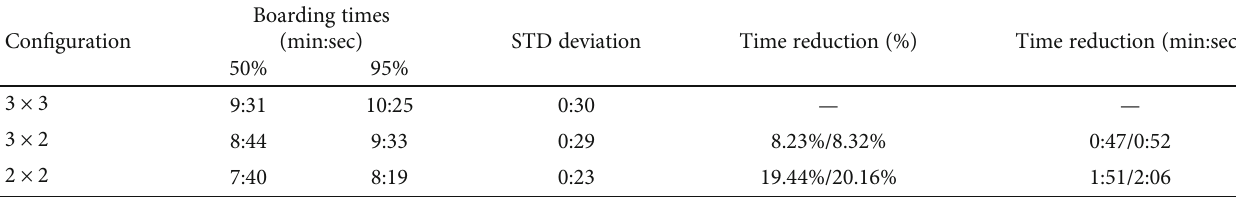
Table 2: Comparison of boarding times for the three aircraft con fi gurations using the random boarding strategy. Con fi